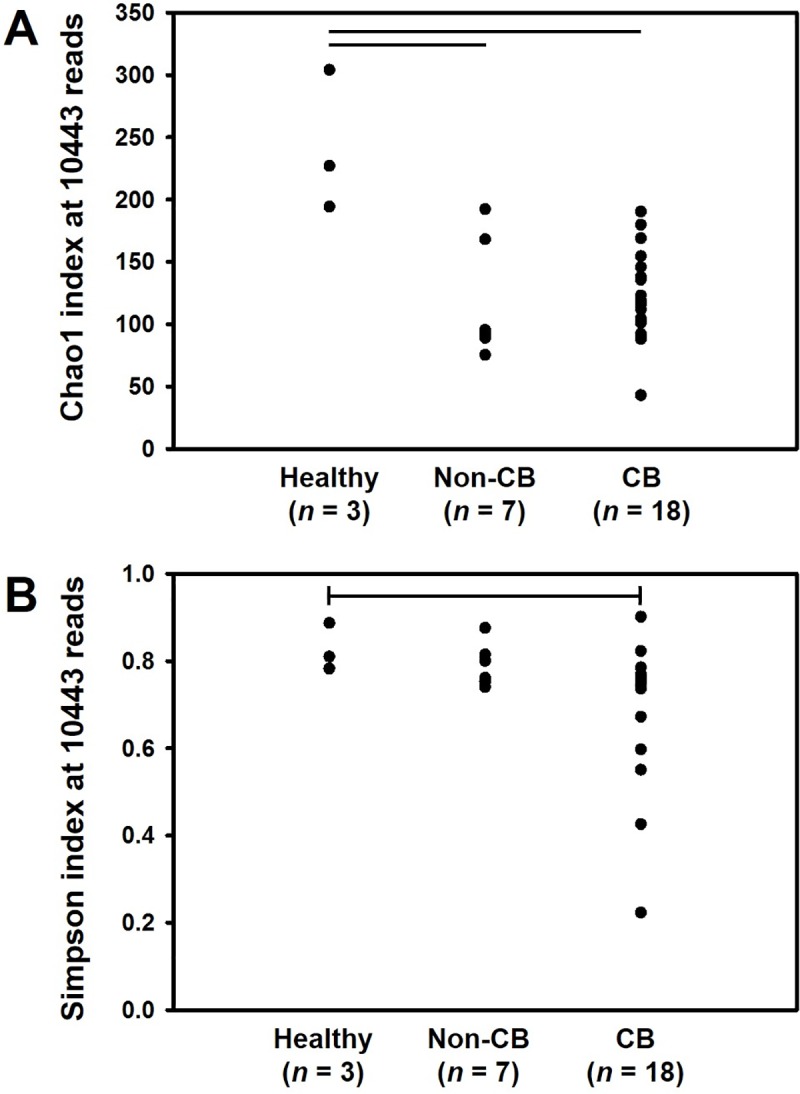
Dot plots showing the Chao1 (A) and Simpson (B) indices, calculated using a uniform number of randomly subsampled reads (10443/sample), of bronchoalveolar lavage fluid from healthy research dogs (n = 3), dogs diagnosed with non-bronchitic chronic respiratory disease (non-CB, n = 7), and dogs diagnosed with chronic bronchitis (CB, n = 18). Significant overall and pairwise differences (p = 0.001) in A detected via one-way ANOVA; significant overall difference in B detected via Kruskal-Wallis ANOVA on ranks.